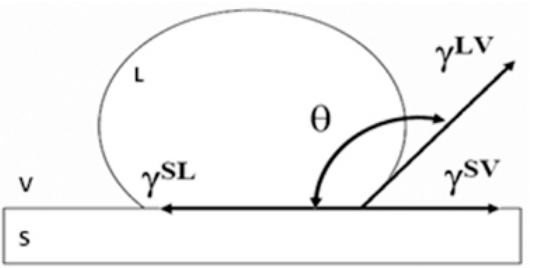
Figure 1. Schematic illustration of an ink drop on a solid substrate with the surface free energy and the contact angle as described by Young’s equation [21].